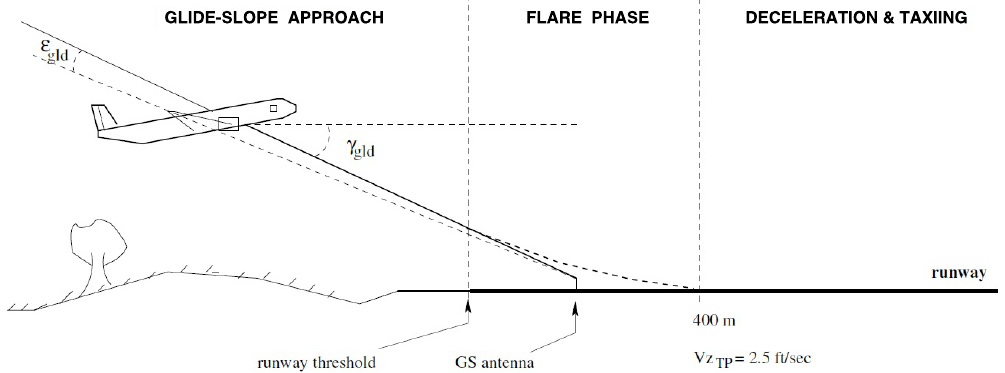
Figure 1. Basic segments of the approach and landing maneuver in a vertical